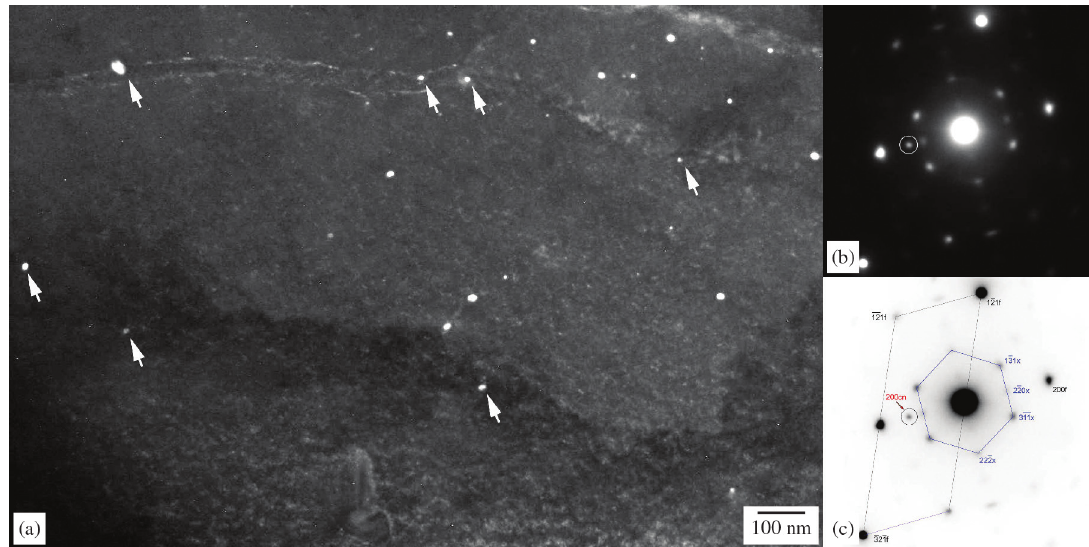
Figure 8. TEM micrograph showing in (a) dark field contrast of fine carbonitrides, indicated by white arrows, on UFG ferrite boundaries. Electron diffraction pattern in (b) and its key diagram in (c) suggest that particles were nucleated in austenite and some oxidation occurred on sample’s surface.